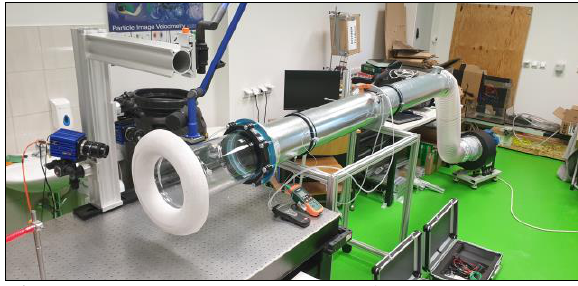
Fig. 17. The experimental line prepared for PIV measurement.